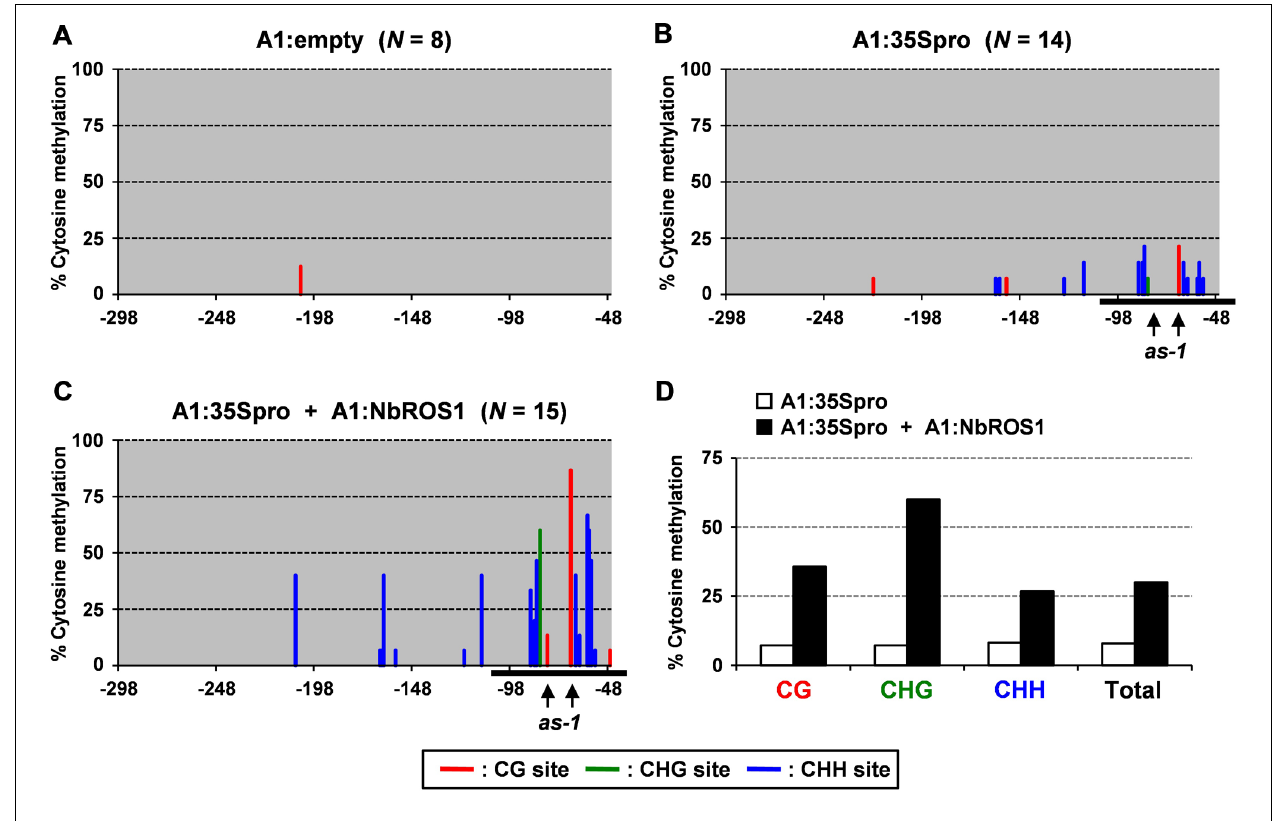
respectively. For plants infected with A1:empty, A1:35Spro, and both A1:35Spro and A1:NbROS1, 8, 14, and 15 clones were sequenced, respectively.The positions of two CG sites in the cis -acting as-1 element, to which binding of protein factor(s) is inhibited by cytosine methylation (Kanazawa etal., 2007b), are indicated by vertical arrows. (D) Summary of bisulfite sequencing analysis of CaMV 35S promoter in plants infected with A1:35Spro and those infected with both A1:35Spro and A1:NbROS1.